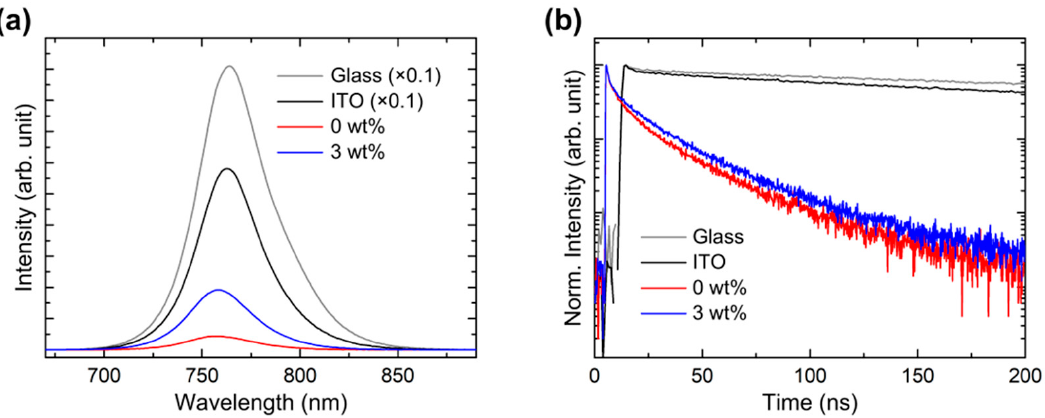
Figure 8. ( a ) Steady-state and ( b ) time-resolved PL spectra of perovskite films on glass, ITO, pristine PEDOT:PSS (0 wt%)/ITO, and 3 wt% Brij C10-mixed PEDOT:PSS/ITO. Table 2. Fitting parameters of time-resolved PL spectra of perovskite films on glass, ITO, pristine